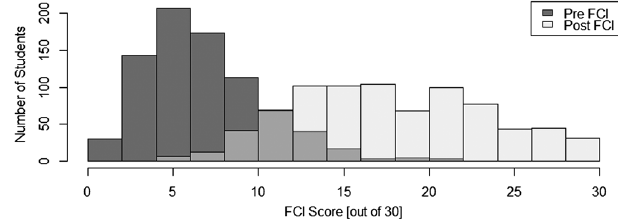
FIG. 1. Histogram of pretest scores (dark gray) and post-test scores (light gray) on the FCI for students at PCSSW. The histograms are overlapping, so the medium-gray scores in the middle are part of the pretest